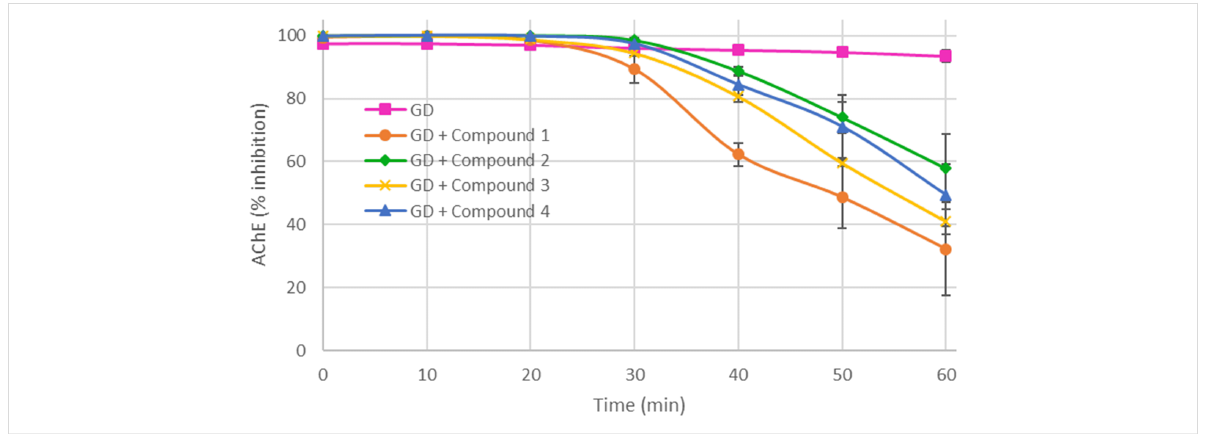
towards methyl parathion was also studied in terms of rate con- stants (Table 2) within the initial 4 minutes. In the presence of derivatives 1 and 4 , 10–11% hydrolysis of the substrate were observed and the catalytic factor increased by 7.1 and 7.5 times, respectively, compared to free IBA.